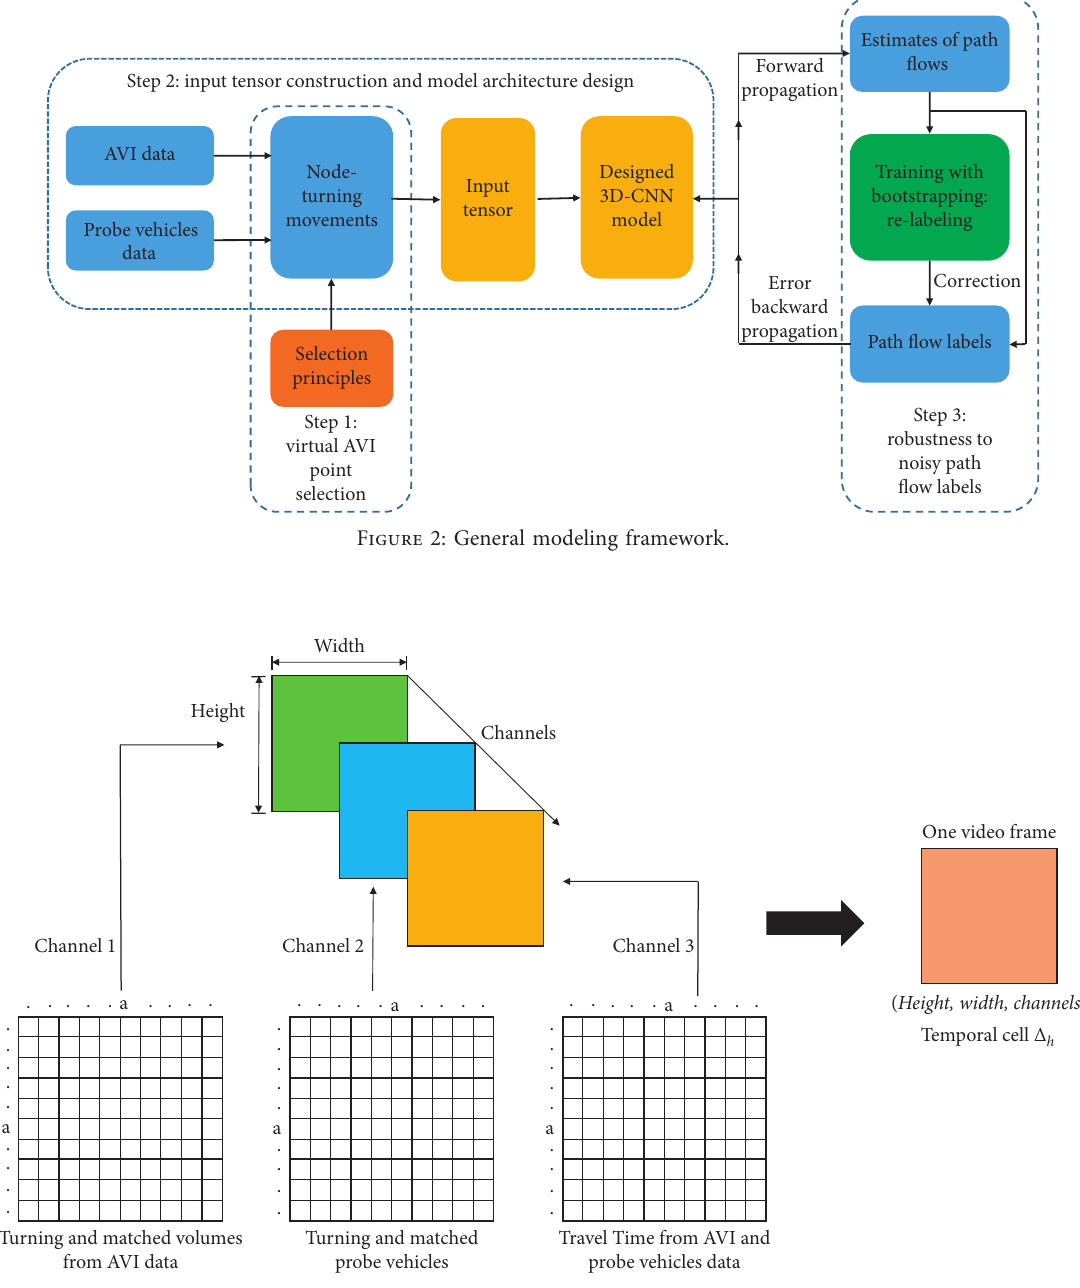
Figure 3: The input tensor for 3D-CNN